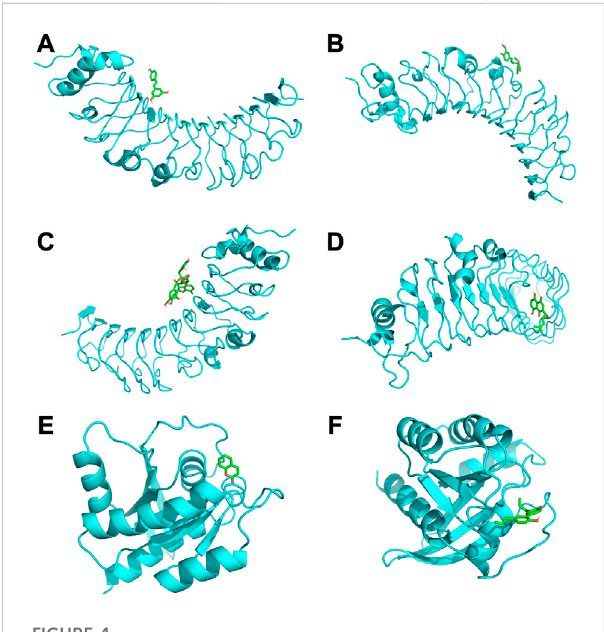
FIGURE 4 (A) shows TLR4 docked with resveratrol ( − 6.2 kcal/mol); (B) shows TLR4 docked with curcumin ( − 5.9 kcal/mol); (C) shows TLR4 docked with salvianolic acid b ( − 7.6 kcal/mol); (D) shows TLR4 docked with shikonin ( − 6.9 kcal/mol); (E) shows KRAS docked with coumarin ( − 6.7 kcal/mol); (F) shows KRAS docked with magnolol ( − 6.9